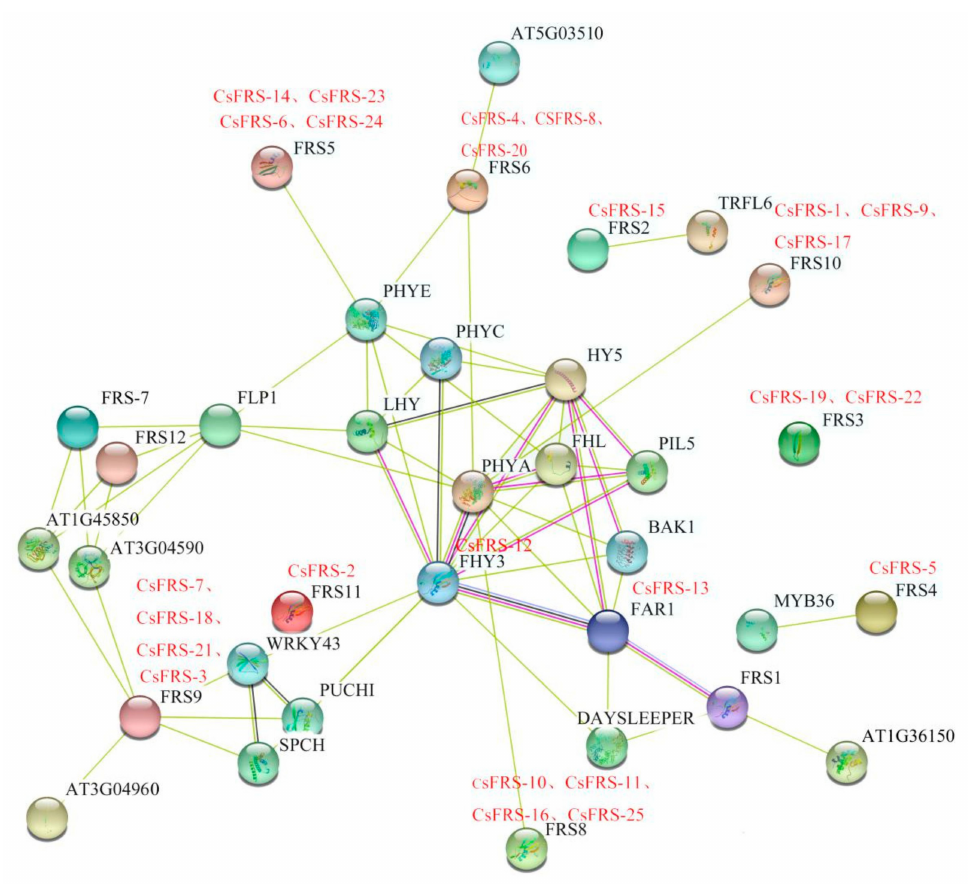
Figure 4. Putative interaction network of CsFHY3/FAR1s in tea plants. The homologous proteins in tea plants and Arabidopsis are shown in red and black, respectively.